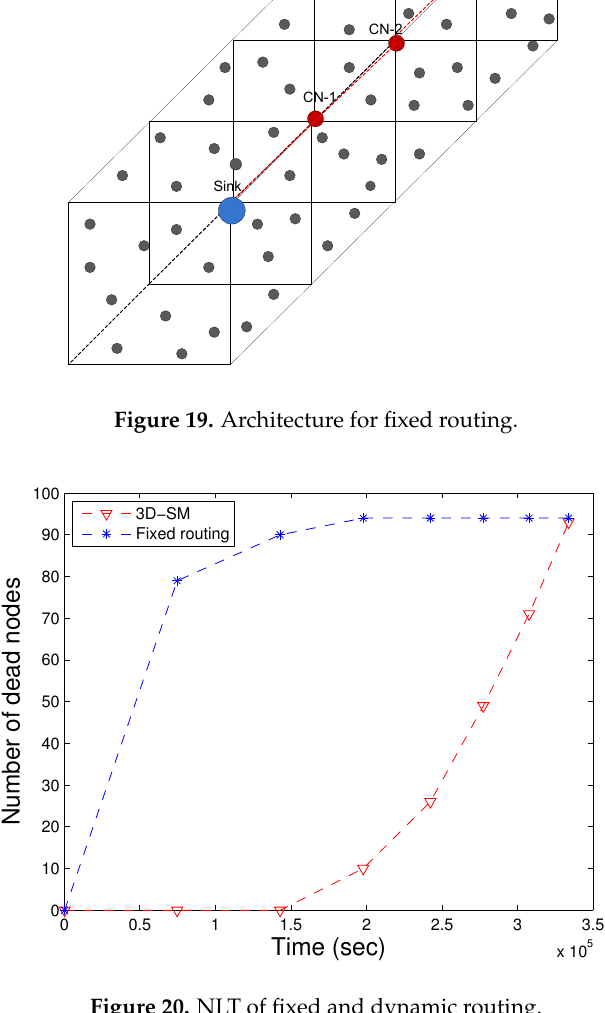
Figure 20. NLT of fixed and dynamic